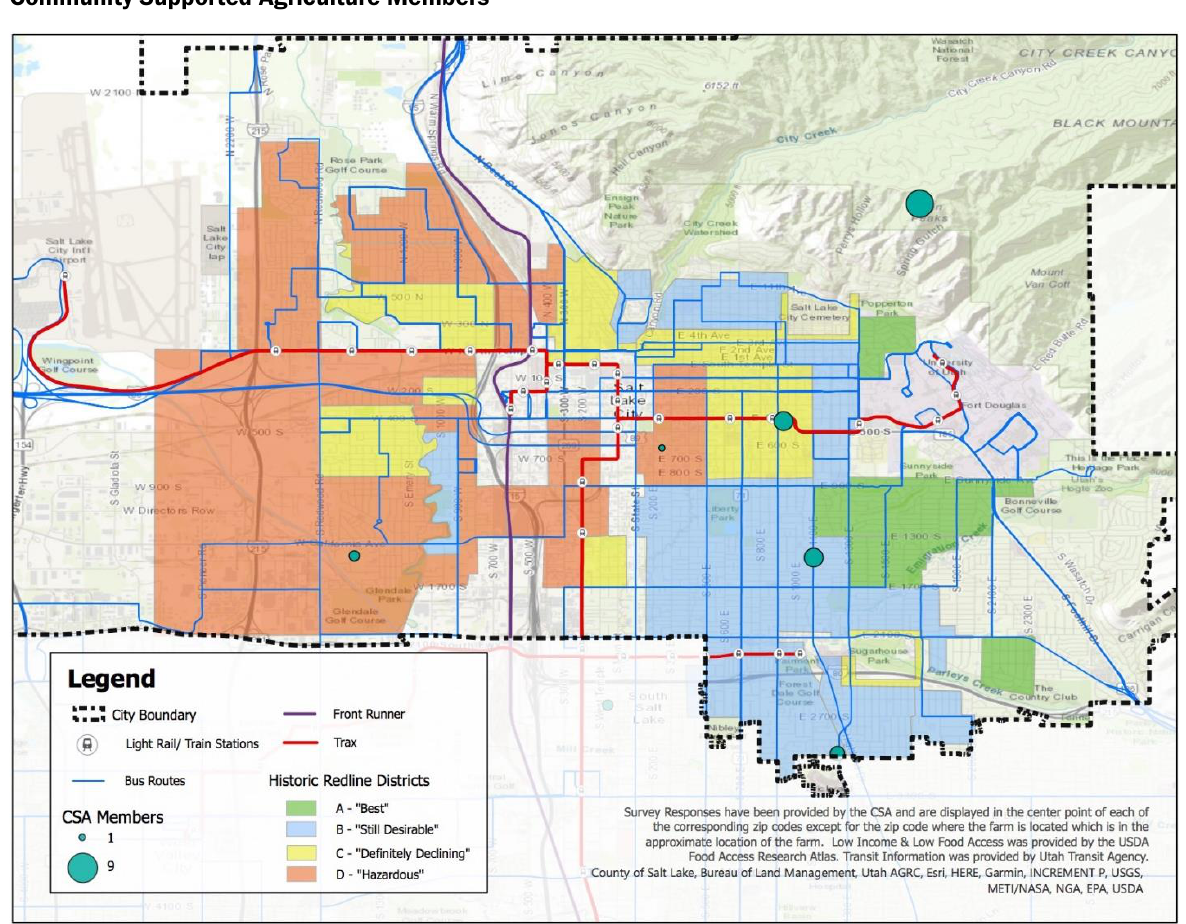
Figure 2. Homeowners Loan Corporation (HOLC) 1930s Redlining Zones and Distribution of B.U.G. Farms Community Supported Agriculture